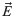
Detection of cells at the tips of sprouts.A-C detection of sprouts in a network. A Skeleton with branch points and end points. B Skeleton from which all nodes except E→ are removed. C The union of the nodes and the connected component in B that contains E→. The node that, in C, is part of the same connected component as E→ is the branch point B→. D detection of cells at the sprout tip (red vertices), which are farthest away from the branch point vB (black vertex).